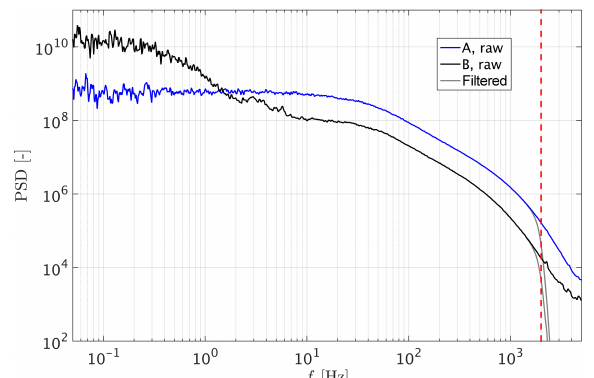
Figure A1. Power spectral density (PSD) of u ( t ) for the Gaussian inflow A (blue) and the intermittent inflow B (black). The effect of a sixth-order Butterworth low-pass filter at f cut = 2kHz is shown in gray. The dashed red line marks f cut = 2kHz.